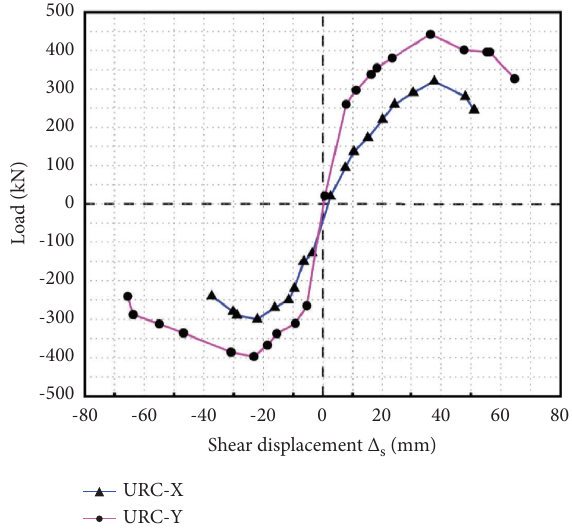
Figure 17: Comparison of skeleton curves of each